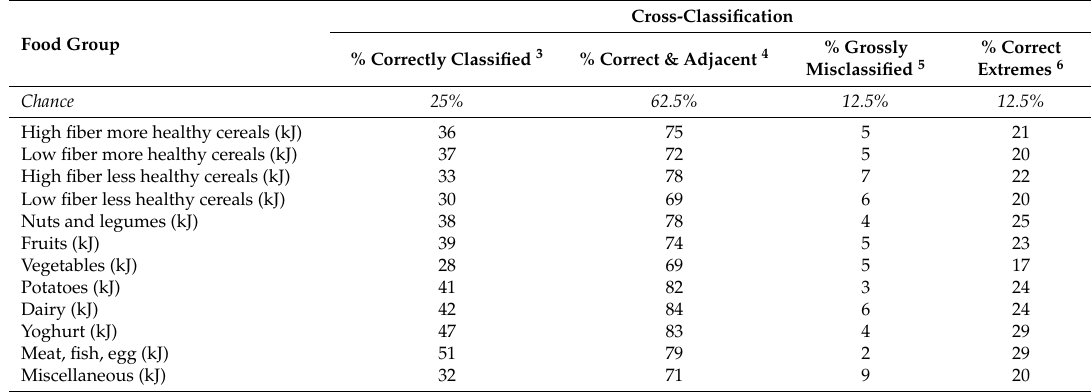
Table 7. Food group (energy contribution) cross-classifications between EAT5 FFQ and WDR quartiles in 5-year old children ( n = 100) 1,2 .